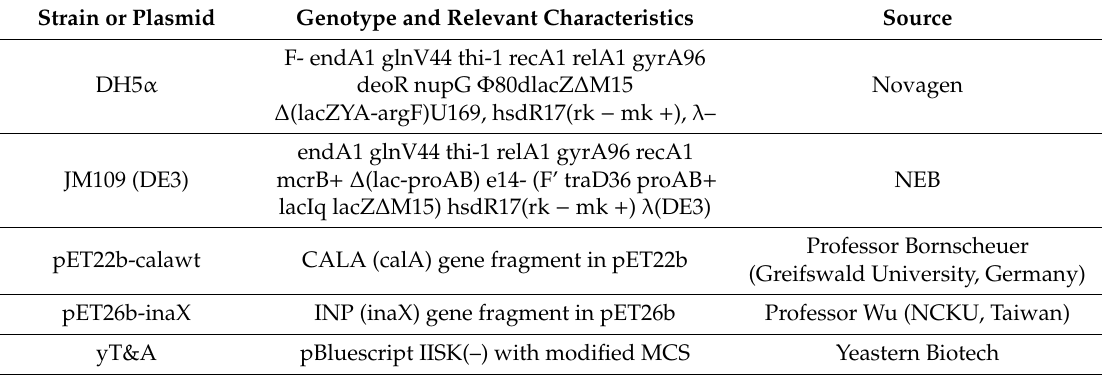
Table 4. E .coli strains and plasmids used in this study. INP: ice nucleation protein. Table 4. E. coli strains and plasmids used in this study. INP: ice nucleation protein. Strain or